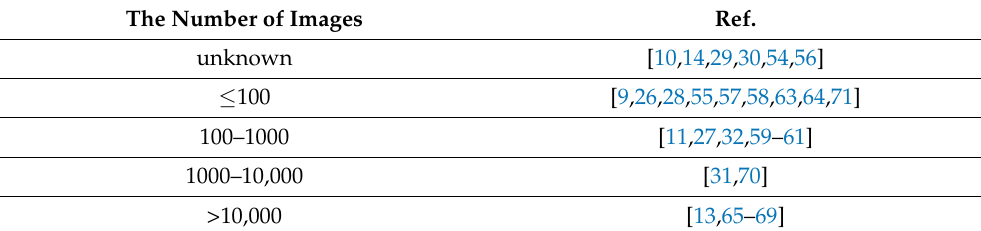
Table 12. The study of the distributions by the number of images in Figure 10b. The Number of Images